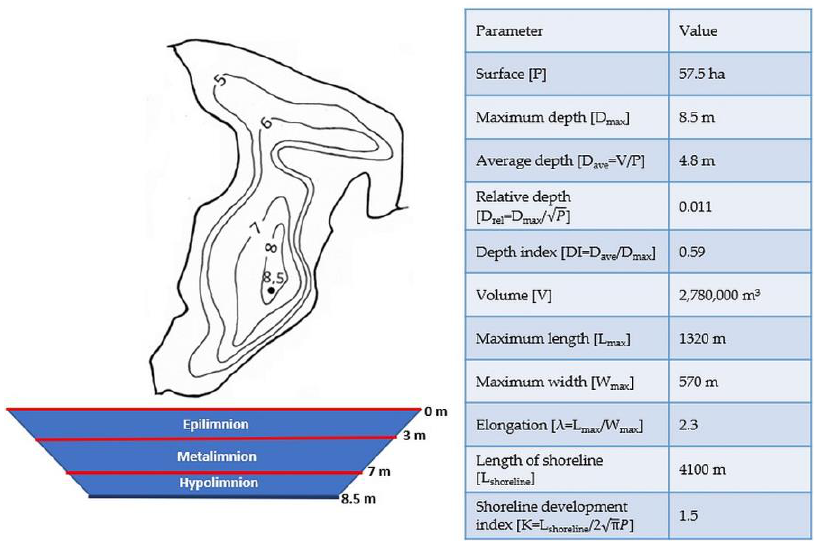
Figure 3. Morphometric data of Lake Klasztorne Duże (Inland Fisheries Institute in Olsztyn). Lake Klasztorne Duże is a stratified, dimictic water body with high water dynamics, which is related to its small depth (8.5 m) with an area of 60 ha. In autumn and spring, this lake is fully circulating. Lake Klasztorne Duże is a eutrophic lake.